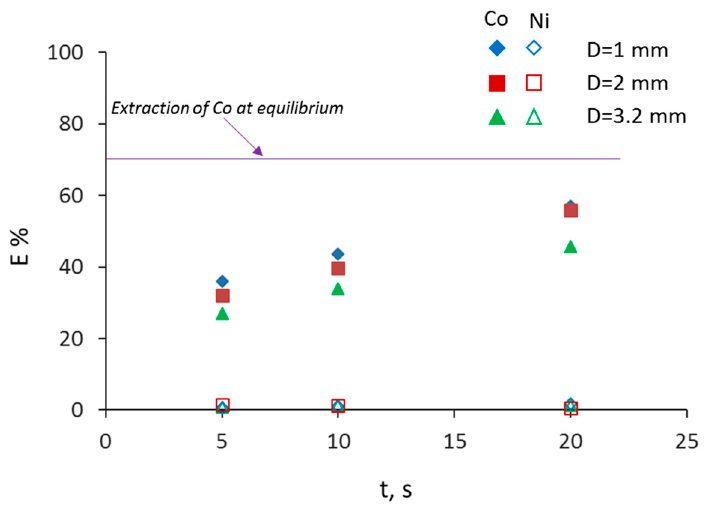
Figure 8. Extraction percentage of Co(II) and Ni(II) as a function of residence time (t) at different channel sizes at constant mixture velocity (u mix = 0.017 m/s).